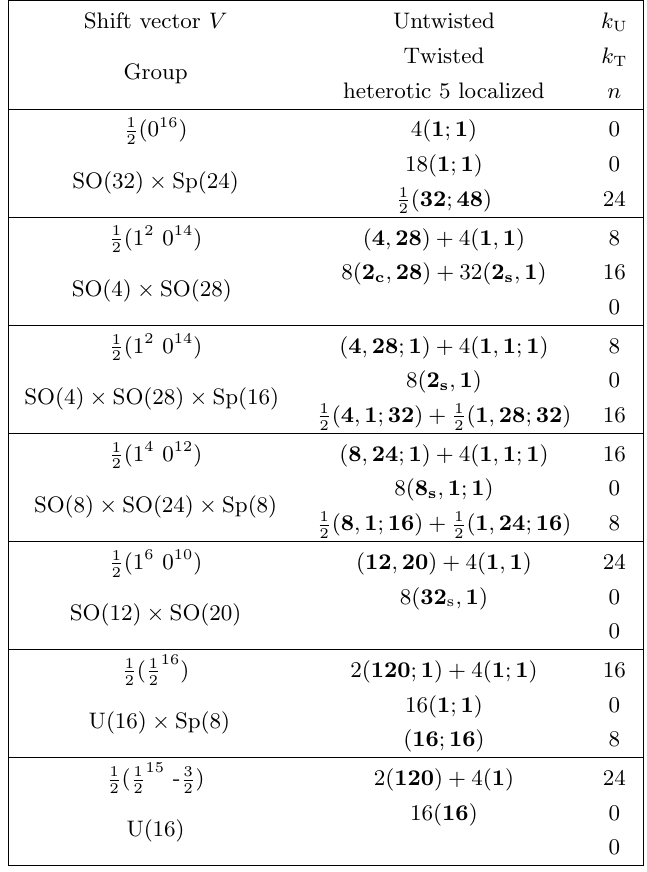
Table 3 . Perturbative ( n = 0) and non-perturbative vacua of SO(32) heterotic string on T 4 = Z 2 orbifold. k U ; k T ; n are small instanton number, the number of heterotic 5-branes and the number of heterotic 5-branes. These are all the inequivalent vacua satisfying the modular invariance condition up to Weyl